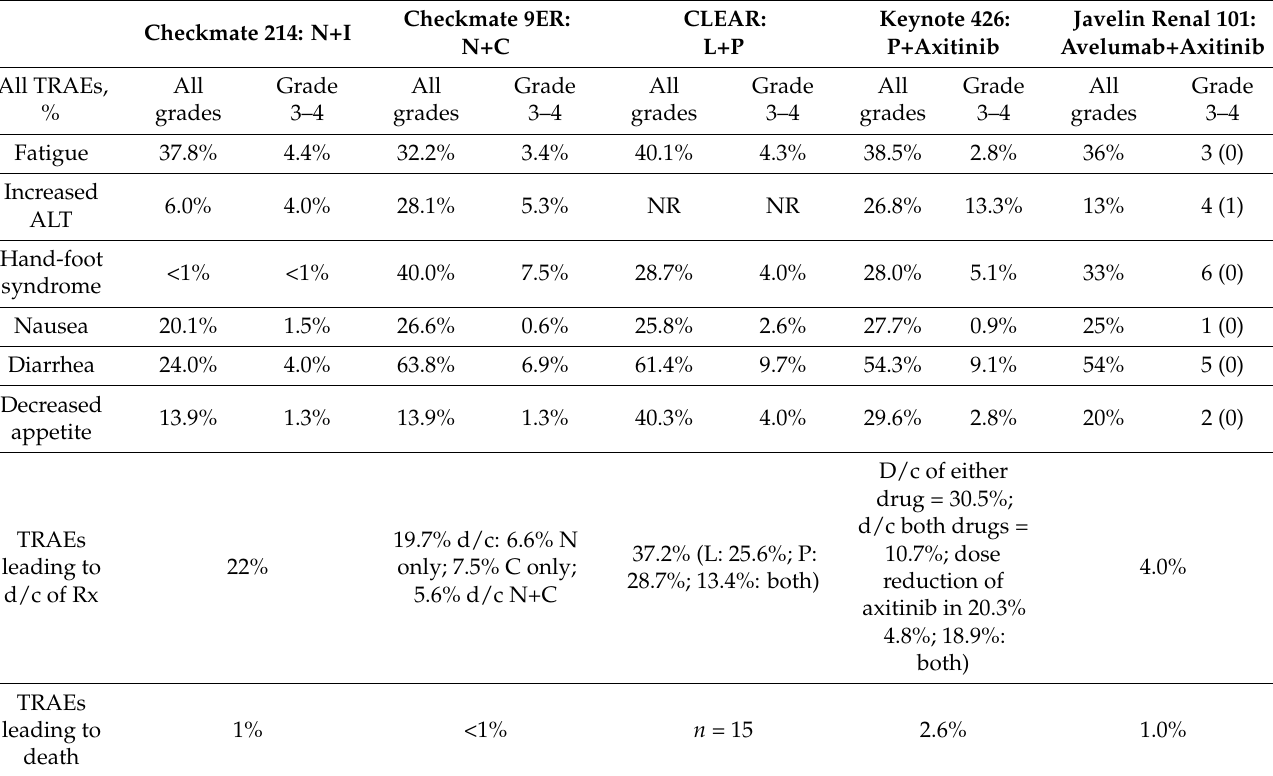
Table 2. mRCC first-line immunotherapy trials: toxicity